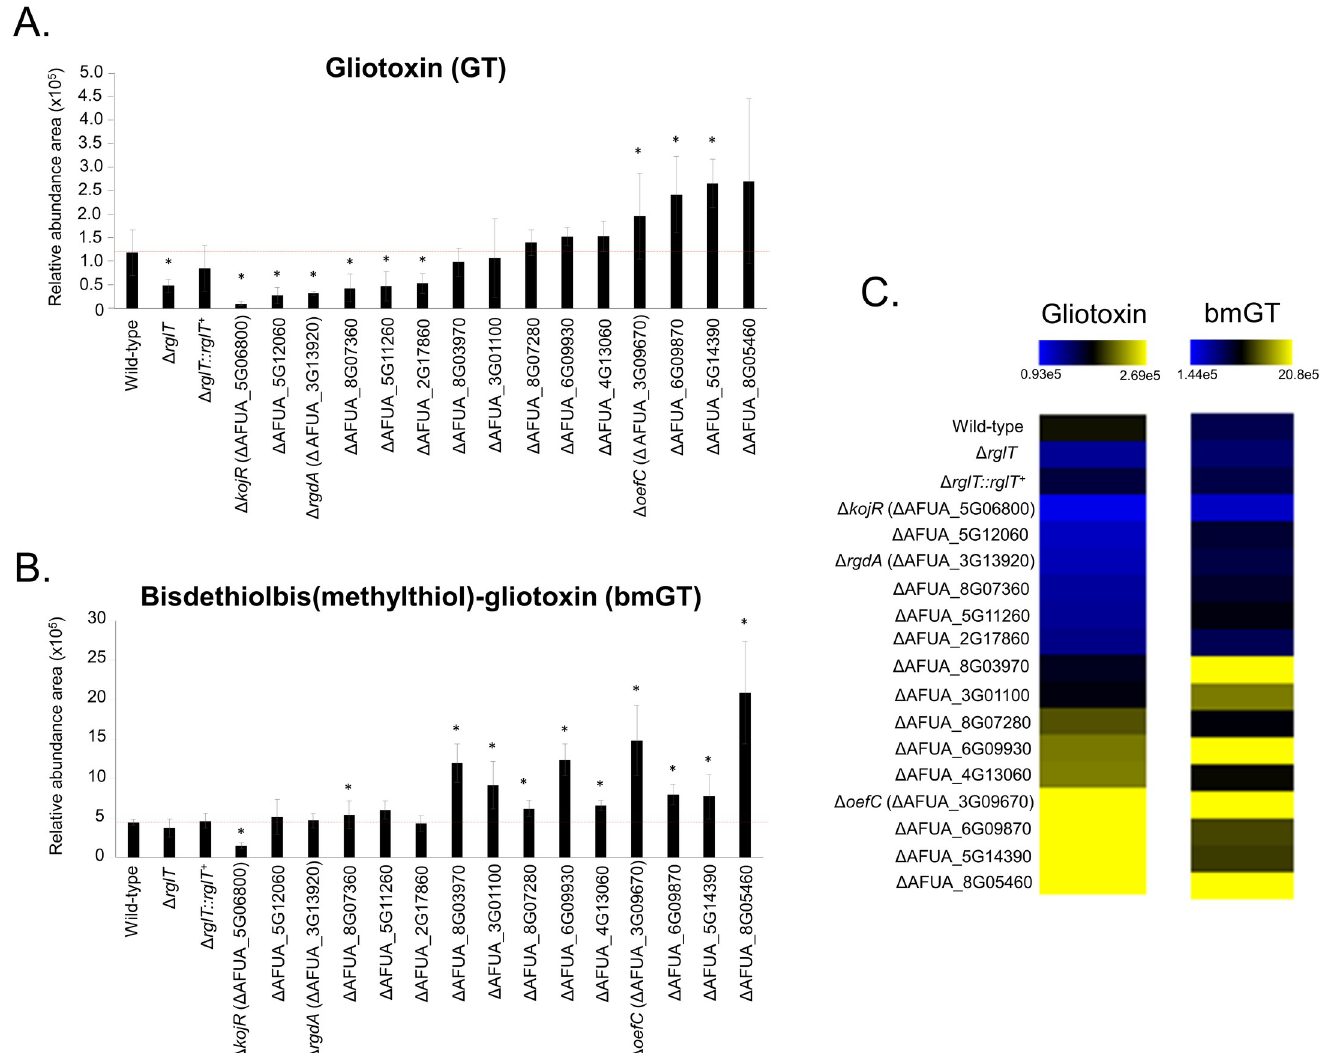
Fig 7. Production of GT and bmGT in the A . fumigatus GT-sensitive TF deletion strains. (A) Relative abundance of GT and (B) bisdethiobis(methylthio)- gliotoxin (bmGT) as measured by high performance liquid chromatography coupled to mass spectrometry. Results are the average of three repetitions ± standard deviation. Statistical analysis was performed using a one-tailed, paired t-test when comparing quantities to the relative abundance of the WT strain ( � , p < 0.005). (C) Heat map of the results from panels (A) and (B). Heat map scale and gene identities are indicated. Hierarchical clustering was performed in MeV (http://mev.tm4. org/), using Pearson correlation with complete linkage